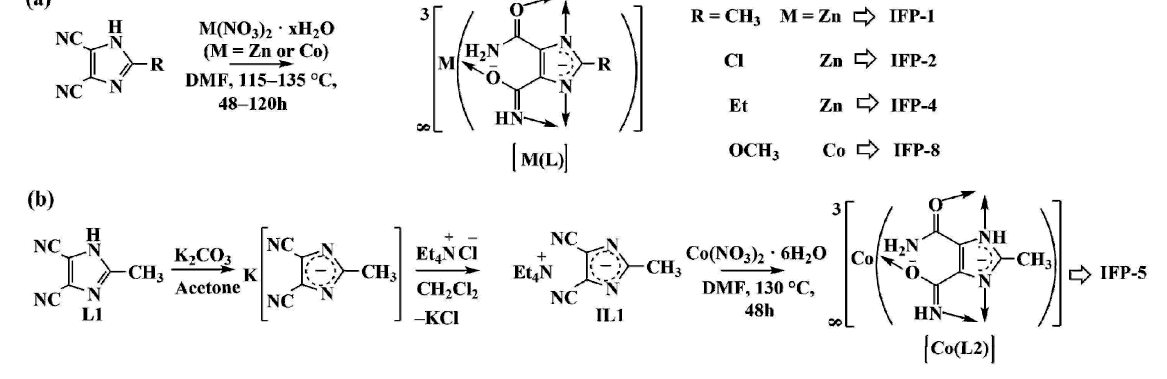
Figure 1. General synthetic strategies for IFP-1, -2, -4 and -8 ( a ) and IFP-5 ( b ), [39–41].